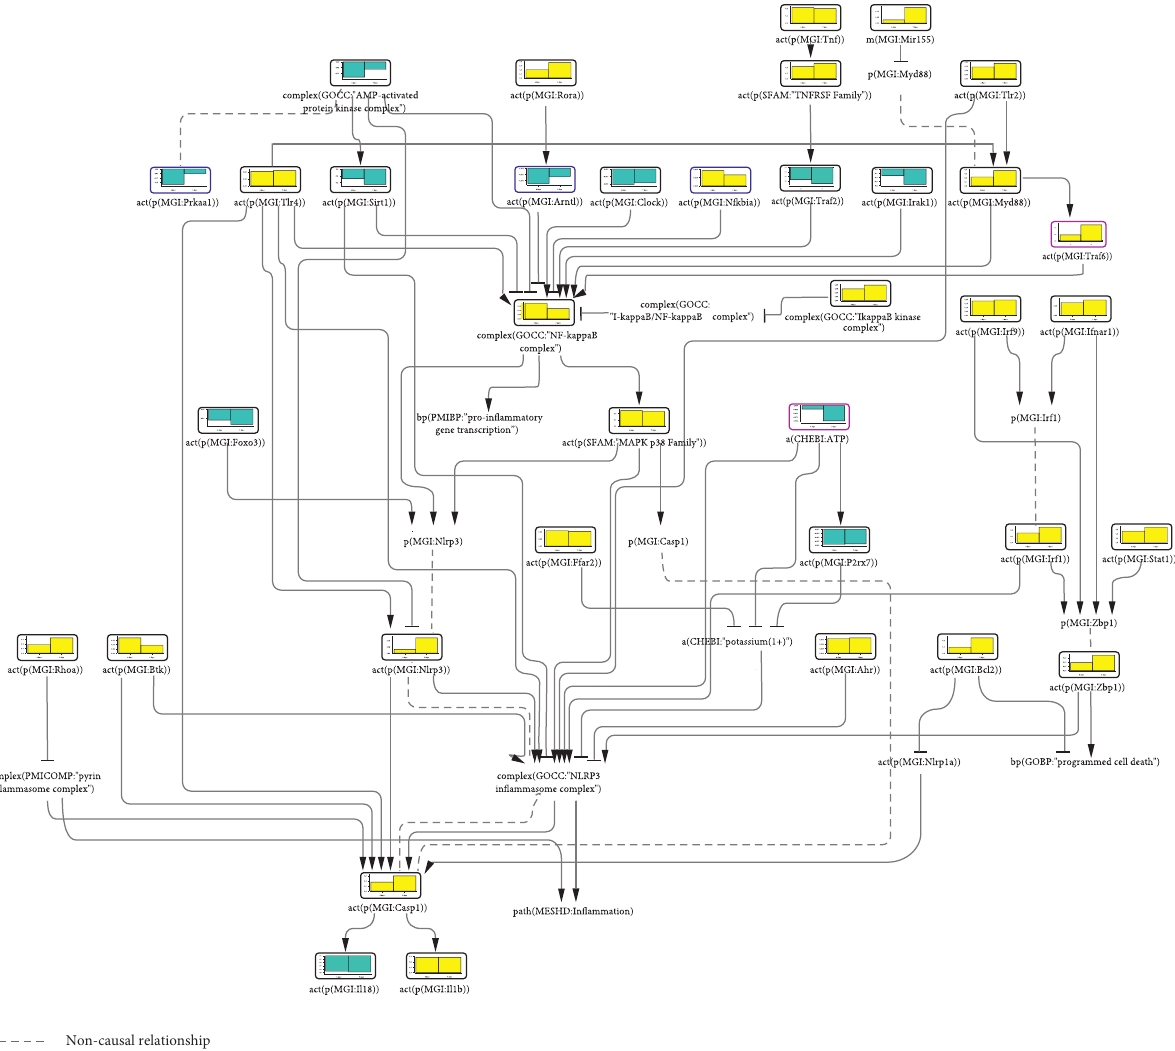
Figure 1: Part of the inflammasome network model scored with transcriptomic data from GSE51386. The bar graph above each node, which was scored, shows the inferred fold change in mouse lung samples at (1) 4 and (2) 7 days post infection (dpi) relative to uninfected lung samples at the same time point. The directionalities are shown as yellow or blue bars for inferred upregulation or downregulation, re- spectively. The black outline refers to nodes that were significantly impacted in both samples at both 4 and 7 dpi, the blue outline refers to nodes that were significantly impacted only at 4 dpi, and the purple outline refers to nodes that were significantly impacted only at 7